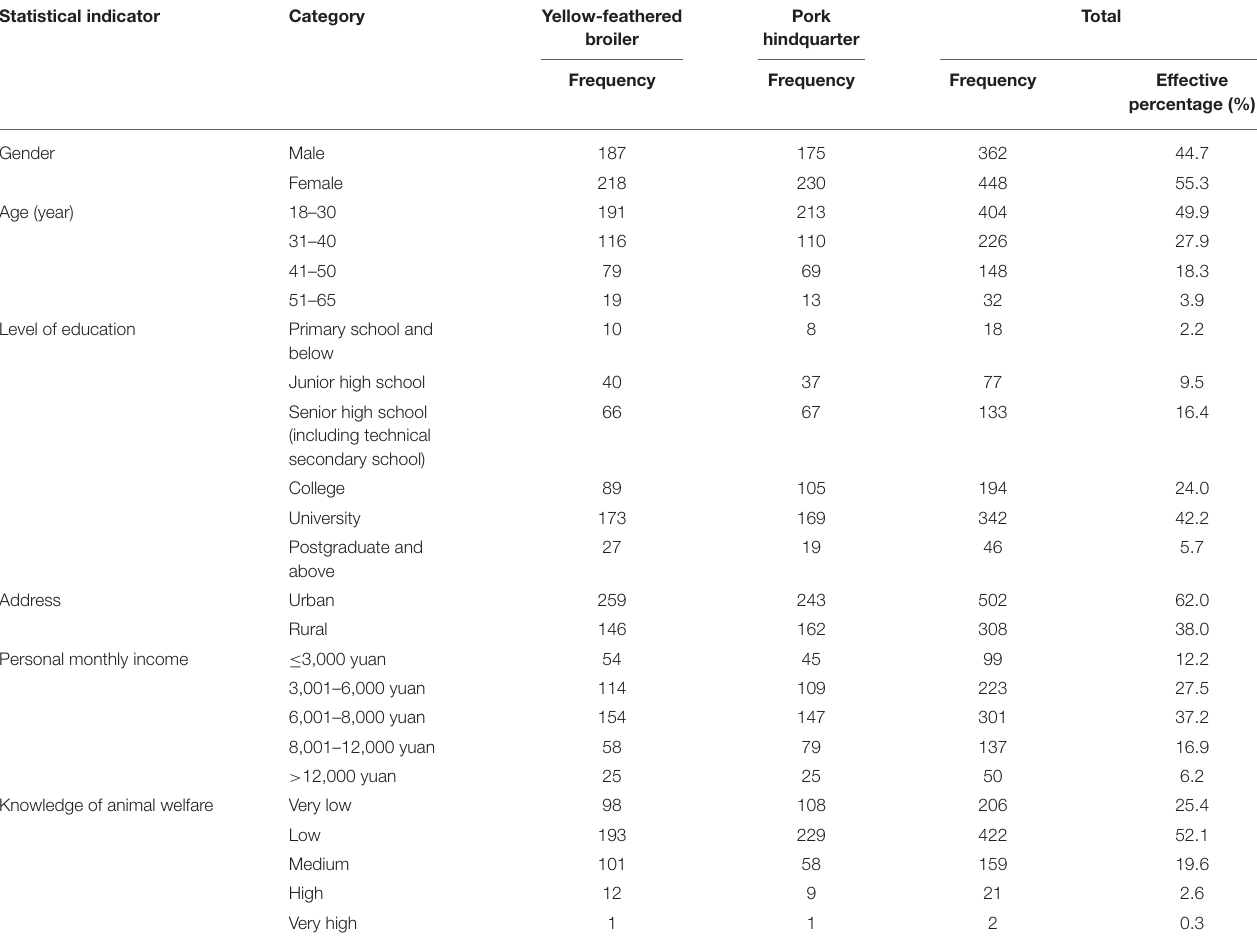
TABLE 3 | Demographic characteristics of